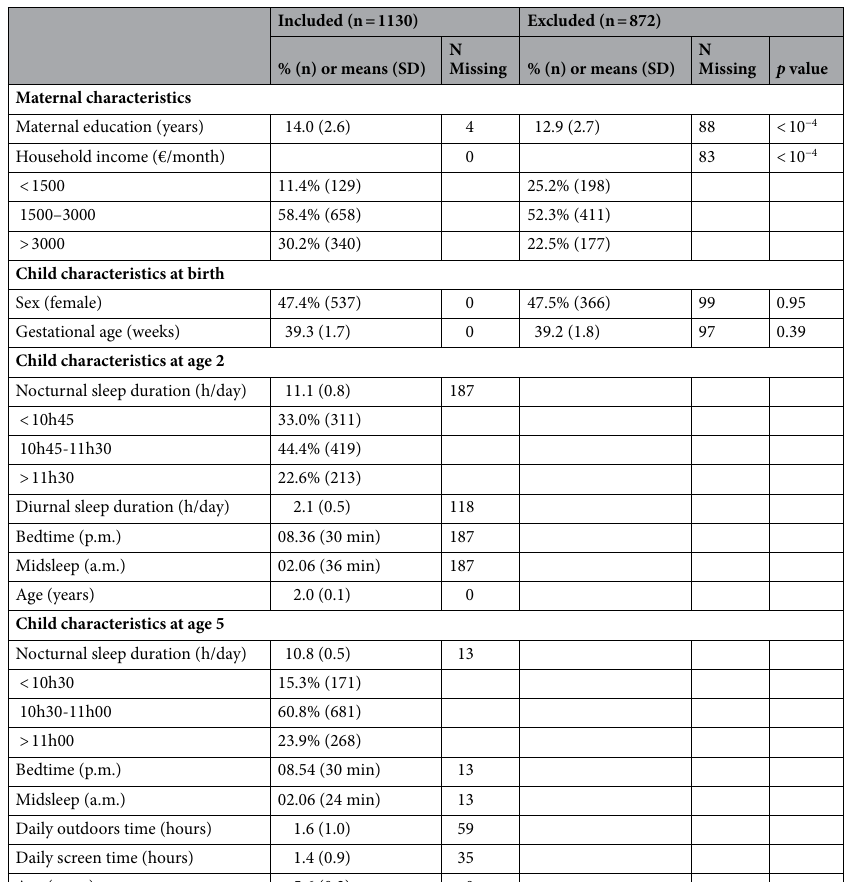
Table 1. Description of included children and comparison with excluded children for information collected at the maternity ward, before